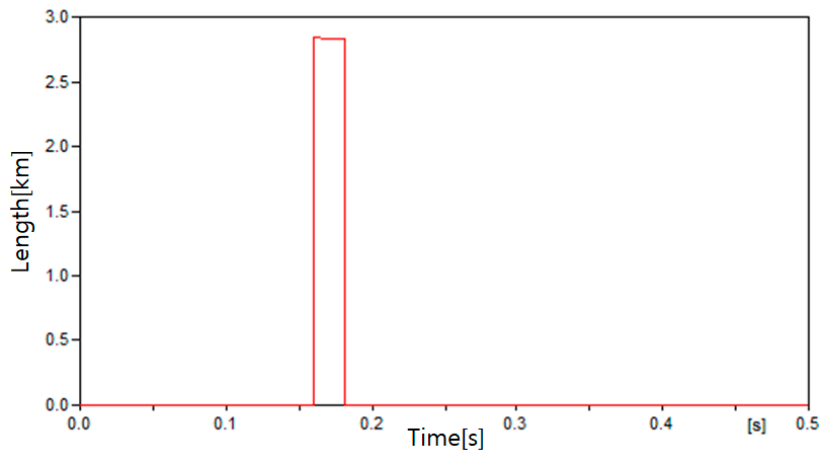
Figure 10. Fault location in Case 2.